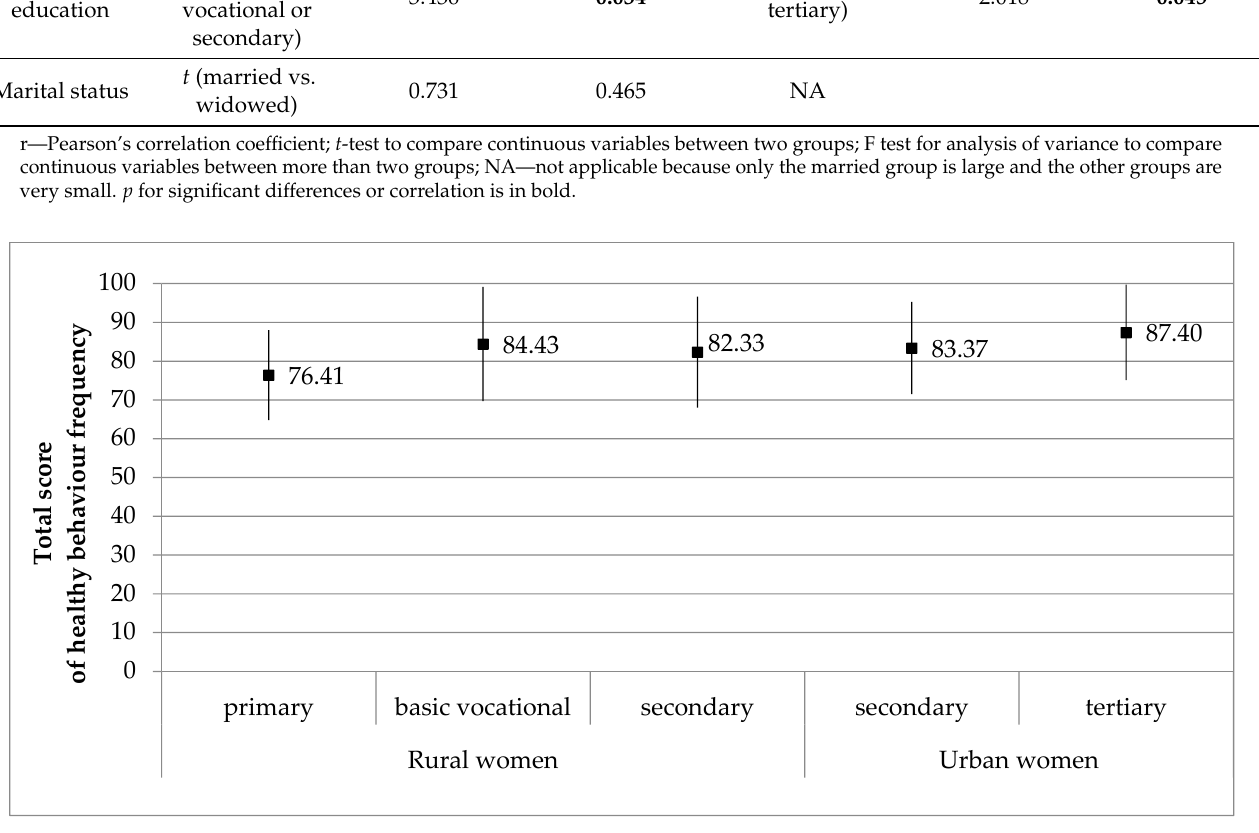
Figure 1. Total score of healthy behavior frequency with level of education in the study groups. Results are presented as M±SD, M—mean, SD—standard deviation.